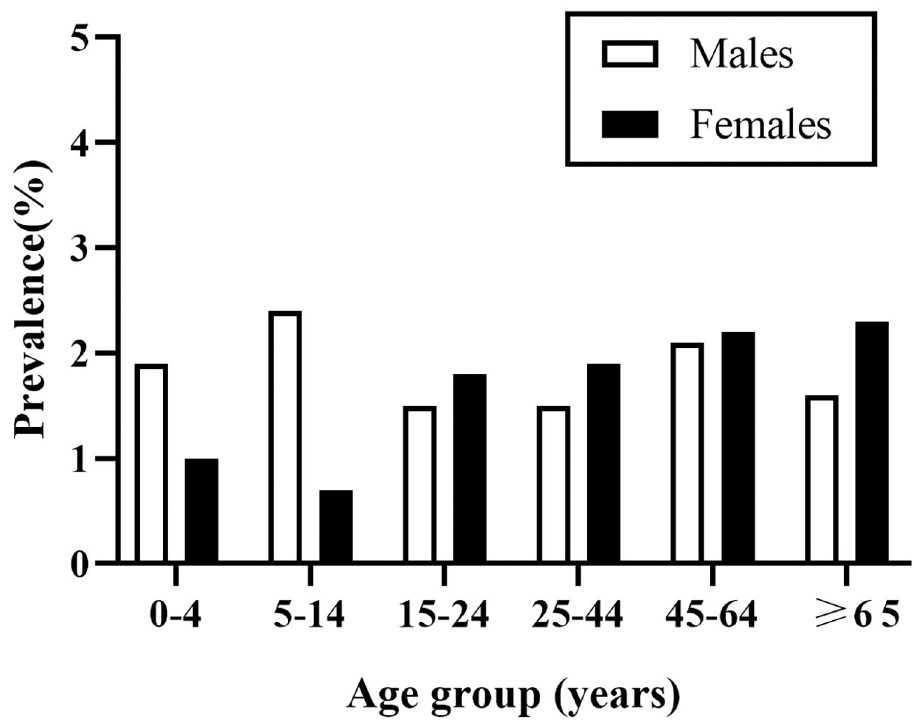
Fig 2. Monthly prevalence of acute gastrointestinal illness by age and sex in the 4 weeks prior to interview in Zhejiang Province, southeast China, July 2018-June 2019.